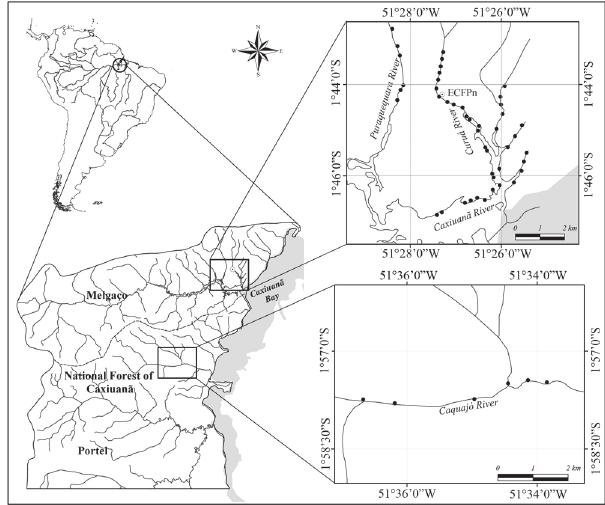
Fig. 1. Sampling area in the National Forest of Caxiuanã, Pará State, showing the rivers where the fish were collected. Curuá River - Ferreira Penna Research Station (ECFPn), Caxiuanã River; Puraquequara River and Caquajó River. Some black spots represent more than one collection